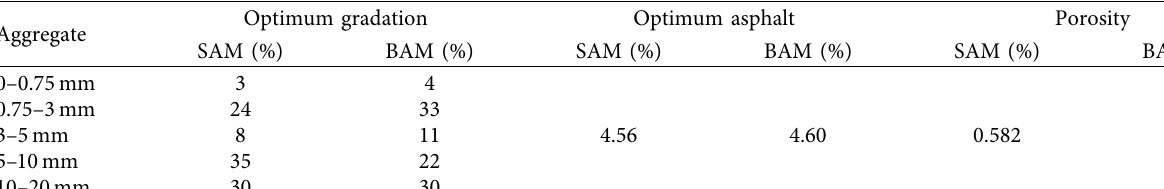
Table 4: Optimum gradation, asphalt content, and porosity.